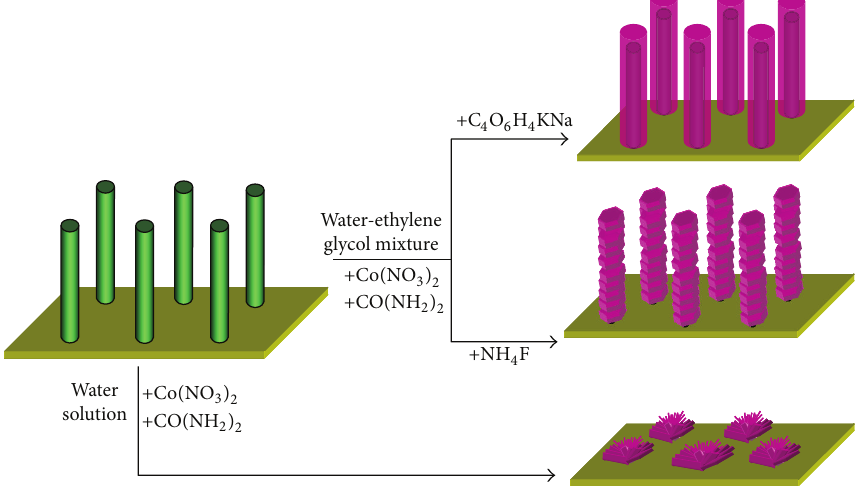
Figure 1: Schematic illustration of different morphologies of CuO/Co 3 O 4